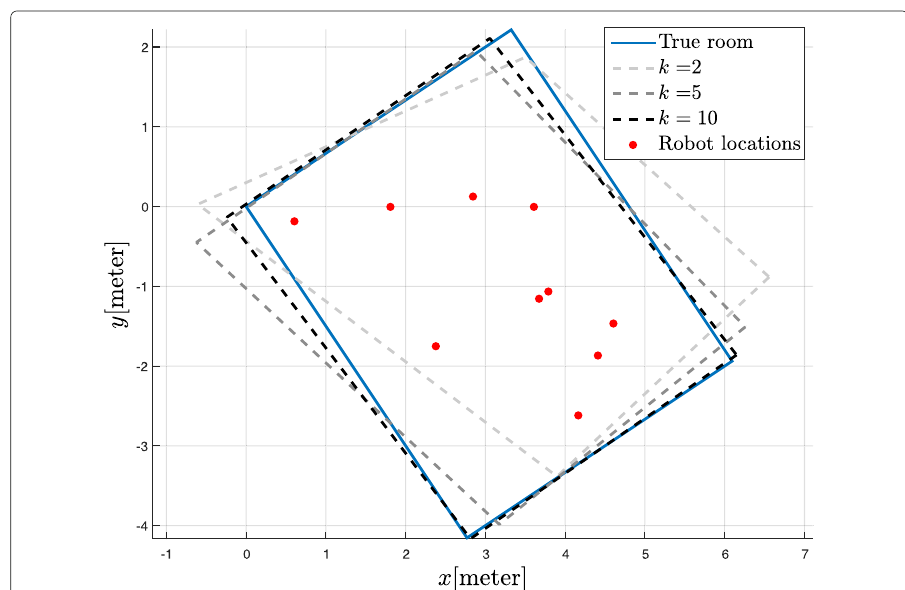
Fig. 7 The estimated room geometry (in meters) via the EKF algorithm at steps k = 2,5,10